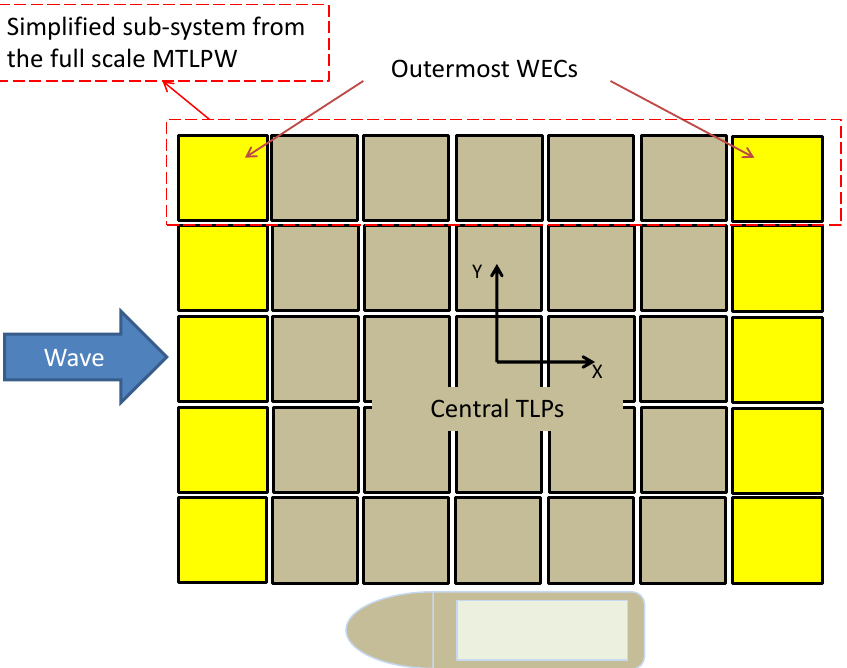
Figure 1. Sketch of the conceptual modular floating structure, which consists of 5 inner tension-leg platforms and 2 outermost wave energy converters (denoted as MTLPW) (in top view).